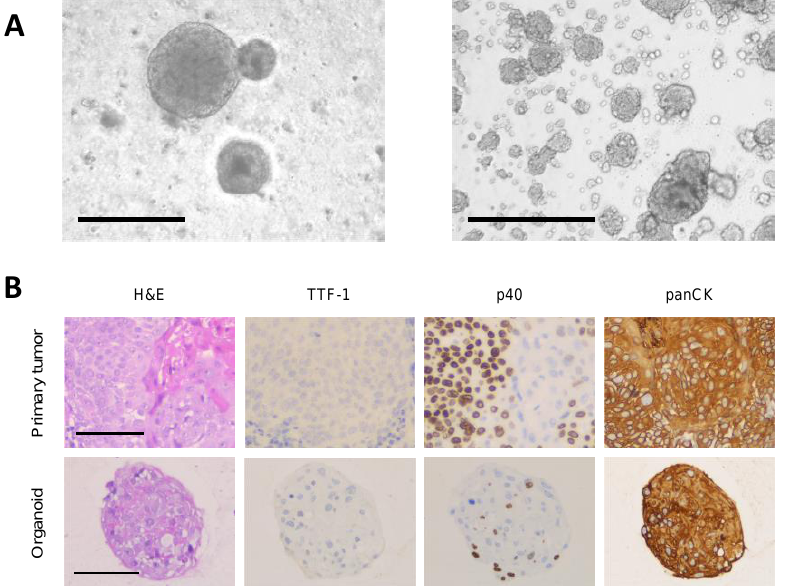
Figure 1. ( A ) Primary NSCLC organoids established from fresh cancer tissue. Left: lung adenocarcinoma organoids, right: lung carcinoid organoids. Scale bar: 100 µ m. ( B ) Histomorphological and immunohistochemical characteristics of primary lung squamous cell carcinoma organoids and their respective parental tissue, featuring intracellular keratinization, intercellular bridges and partial p40 positivity. Scale bar: 100 µ m (unpublished data, Department of Thoracic Surgery, University Hospital Zurich).